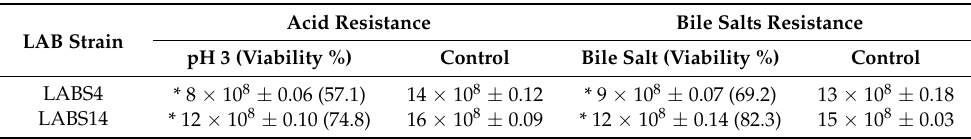
Table 7. Tolerance to acidic pH and 0.3% bile salts evaluated by the viability of LABS4 and LABS14 strains isolated from rainbow trout intestinal content, incubated for 4 h at 37 ◦ C at pH 3.0 or in the presence of 0.3% ( w / v ) bile